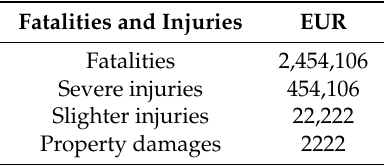
Table 1. Statistical values of causalities avoided per person for fatalities and injured in Sweden [21,29] and per accident for wild boar property damages [11].